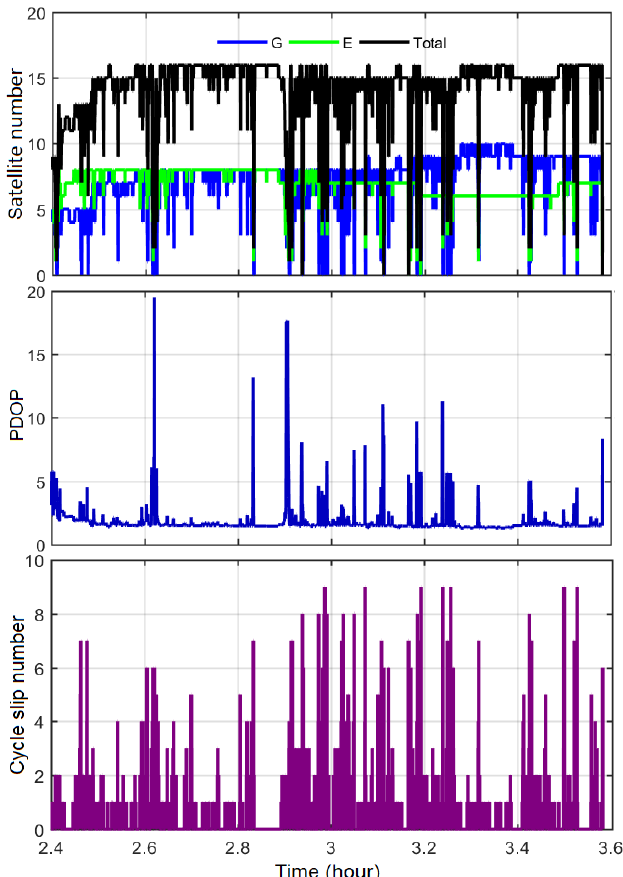
Figure 7. Number of satellites, PDOP and cycle slip tracking of vehicle dynamic observation data.